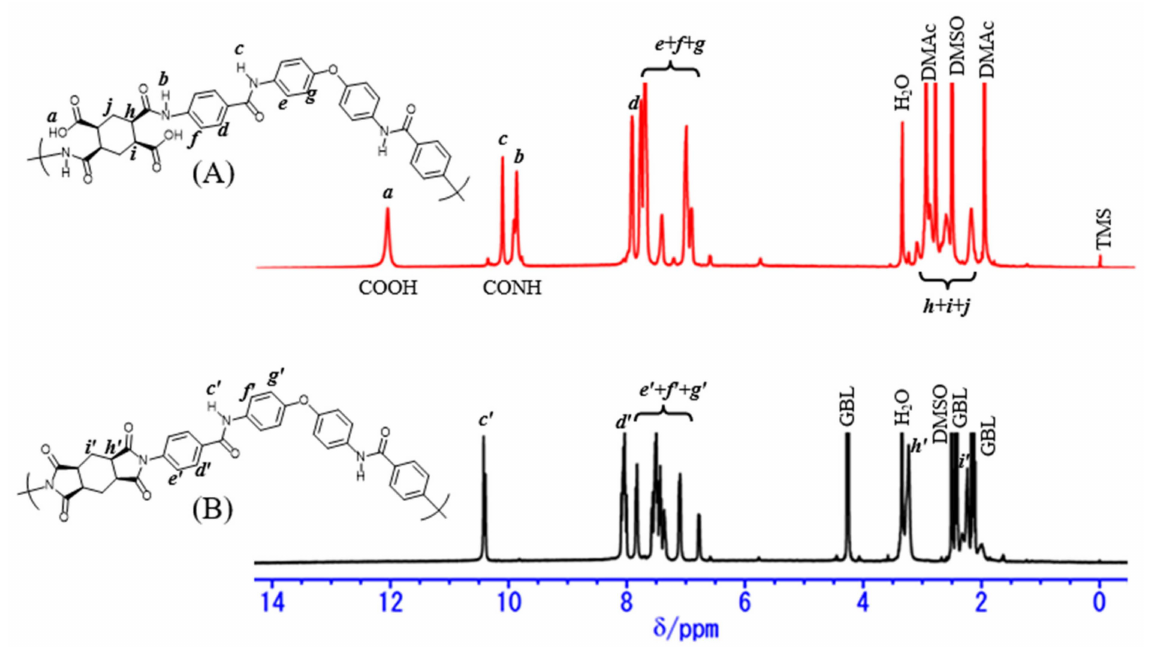
Figure 5. 1 H-NMR spectra (DMSO- d 6 ) of the isolated powder samples for the H-PMDA/AB-44ODA system: ( A ) PAA obtained by polyaddition at room temperature and ( B ) PI obtained via the modified one-pot process.